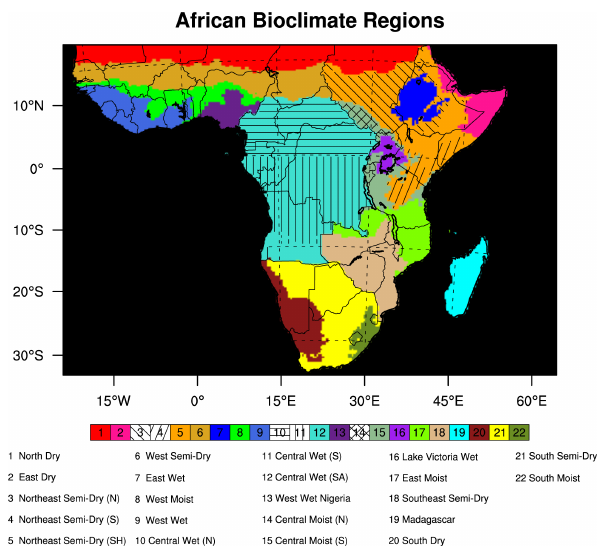
Figure 1. African bioclimate and sub-bioclimate regions defined in this study within the Sub-Saharan